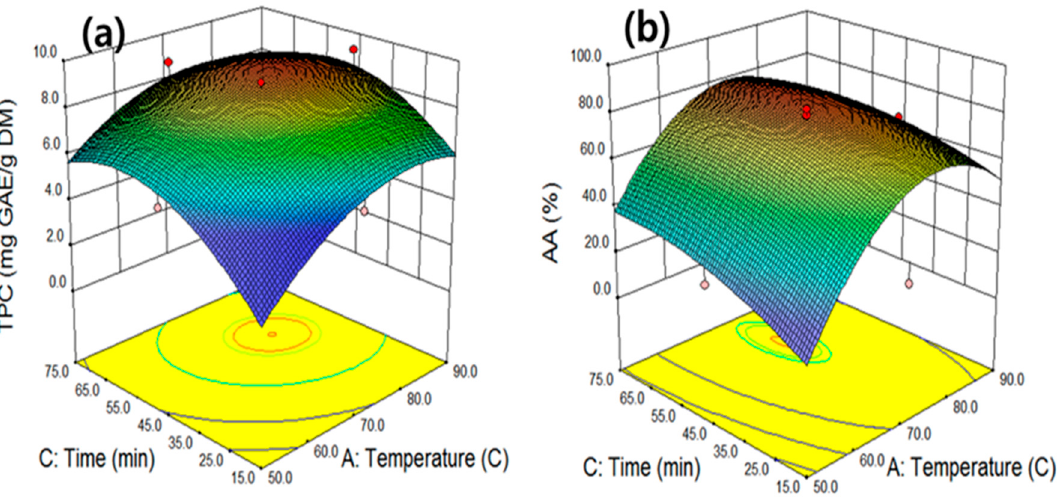
Figure 3. The interactive effects of the extraction temperature and time on total phenolic compounds ( a ) and antioxidant activity ( b ) at fixed levels of ethanol 58.3% and ultrasonic power 500 W.